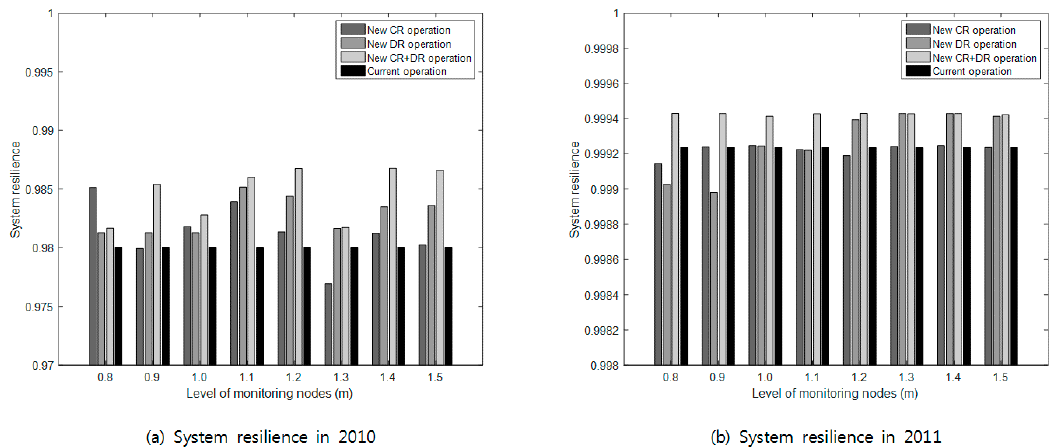
Figure 16. Results of system resilience.